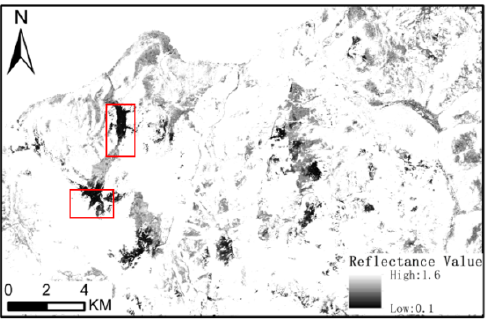
Figure 7. Apparent reflectance value of near-infrared images on a certain day, where the pixels in the red frame are under the shadow of clouds.